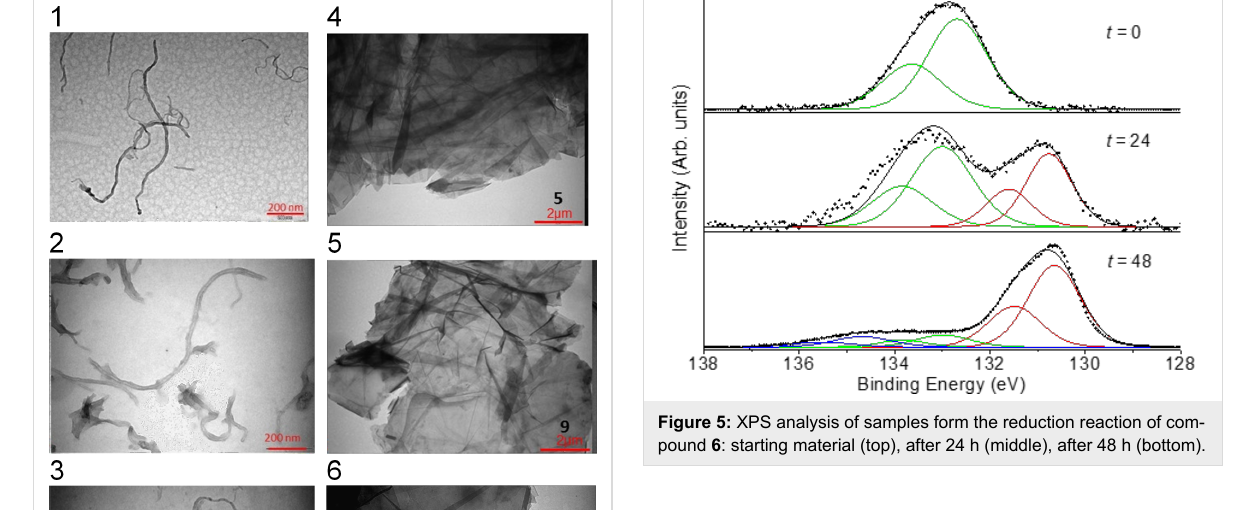
phosphorus atoms, appeared at 130.8 eV, accordingly